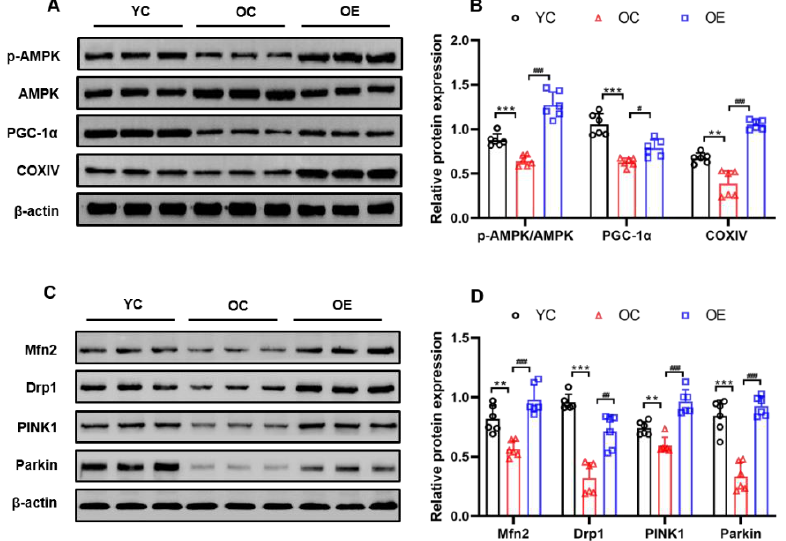
Figure 6. Lifelong aerobic exercise up-regulated the expression of the proteins such as p-AMPK Thr172 /AMPK, PGC-1 α and COXIV associated with mitochondrial biogenesis ( A , B ) and the proteins including Mfn2, Drp1, PINK1, and Parkin ( C,D ) associated with mitochondrial quality control in gastrocnemius muscle of the aged mice evaluated by Western blot. Equal protein loading was confirmed by β -actin. All data are presented as mean ± standard deviation (M ± SD) ( n = 6 mice per group). Group symbols: YC, black circle; OC, red triangle; OE, blue square. *** p < 0.001, ** p < 0.01 vs. YC group; ### p < 0.001, ## p < 0.01 and # p < 0.05 vs. OC group.